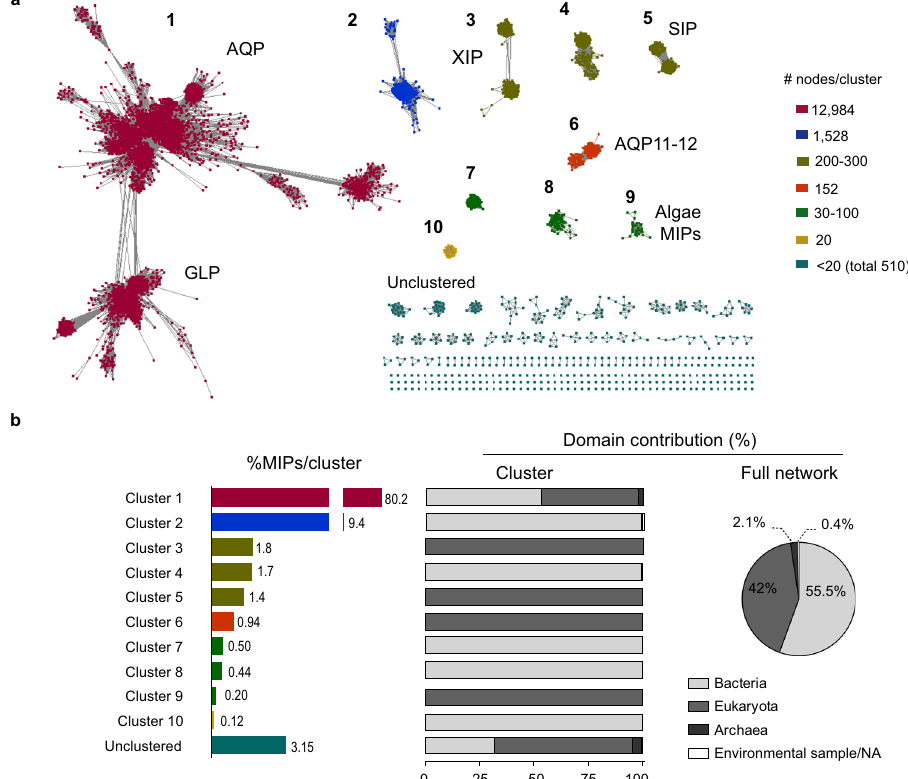
Fig. 1 Sequence similarity network (SSN) of the MIP superfamily. a SSN is composed of 16,170 nodes (squares), which represent proteins sharing >85% sequence identity, connected by edges with an average pairwise alignment score of at least 35. Edge length is a measure of the relative dissimilarity of each pair of sequences. Nodes are colored by the size of each cluster (numbered 1 – 10). Nodes found in clusters with <20 nodes were arbitrarily considered to uncluster. Names indicate clusters containing already characterized proteins. b MIPs distribution among clusters and taxonomic composition of each cluster according to the three-domain system of classi fi cation (Archaea, Bacteria, and